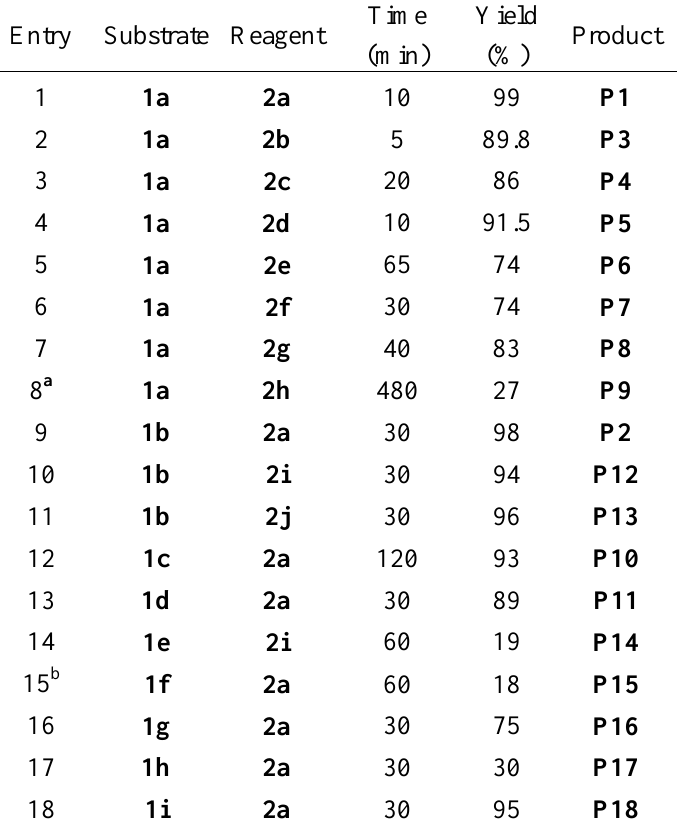
Table 1. Michael additions of thiols to substrates containing activated double bonds